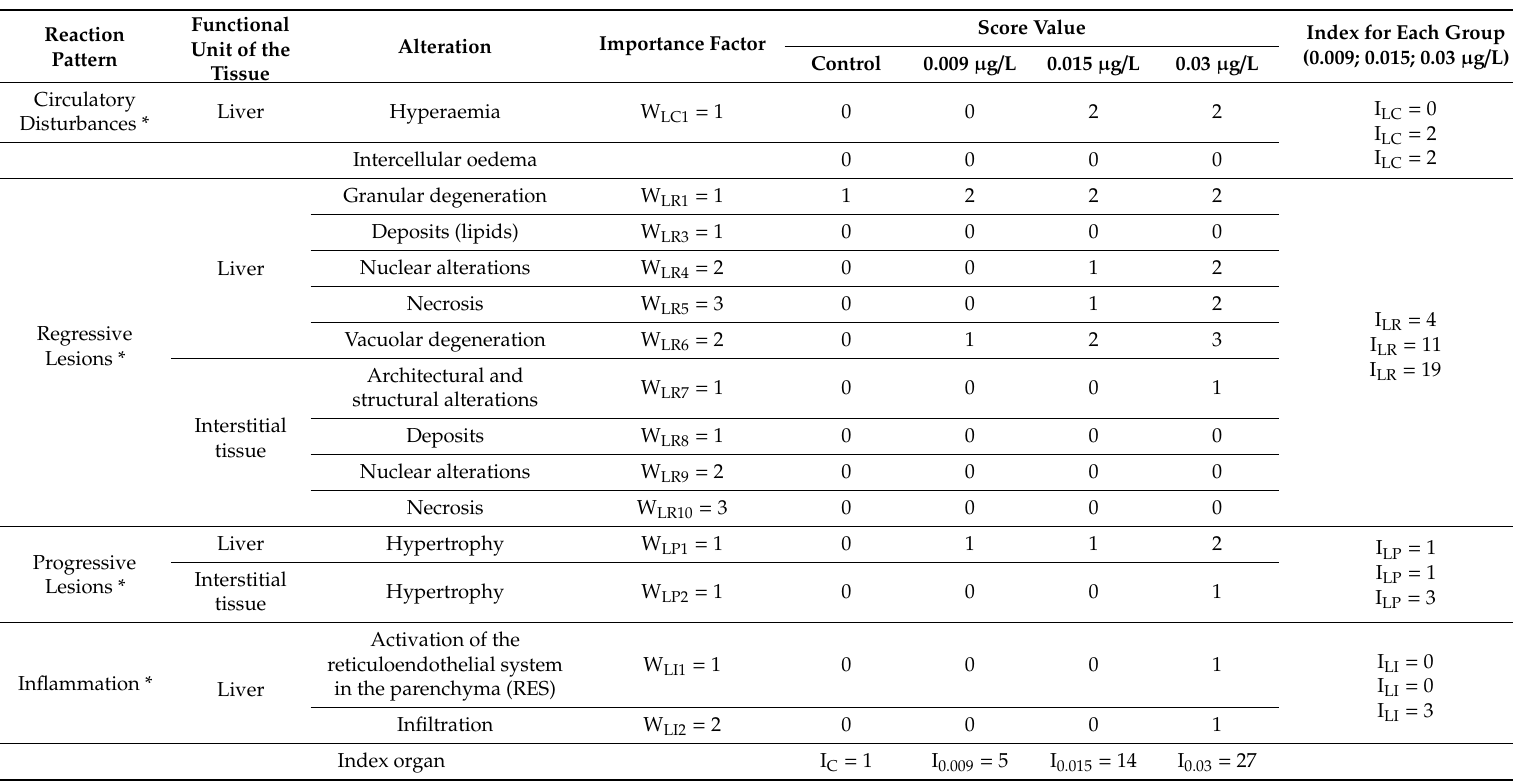
Table 2. Histopathological alterations in the liver of common carp after the exposure with decreasing CPF concentrations based on Directive 2013 / 39 / EU of the European Parliament and of the